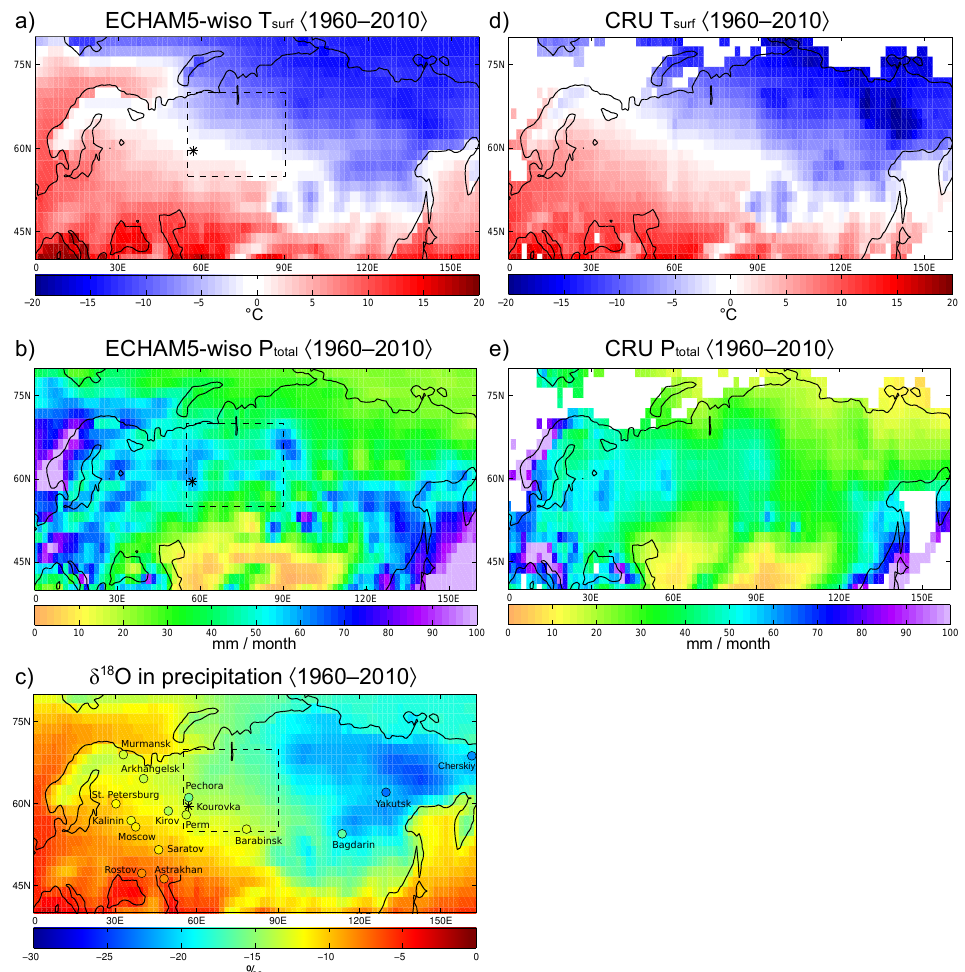
Figure 1. Left column: simulated mean annual values of (a) surface temperature, (b) precipitation, and (c) δ 18 O in precipitation, averaged over the period 1960–2010. Right column: CRU data of (d) surface temperature, and (e) precipitation amount, averaged over the same period. The circles in Fig. 1c mark the position of the various GNIP stations used for analyses in this